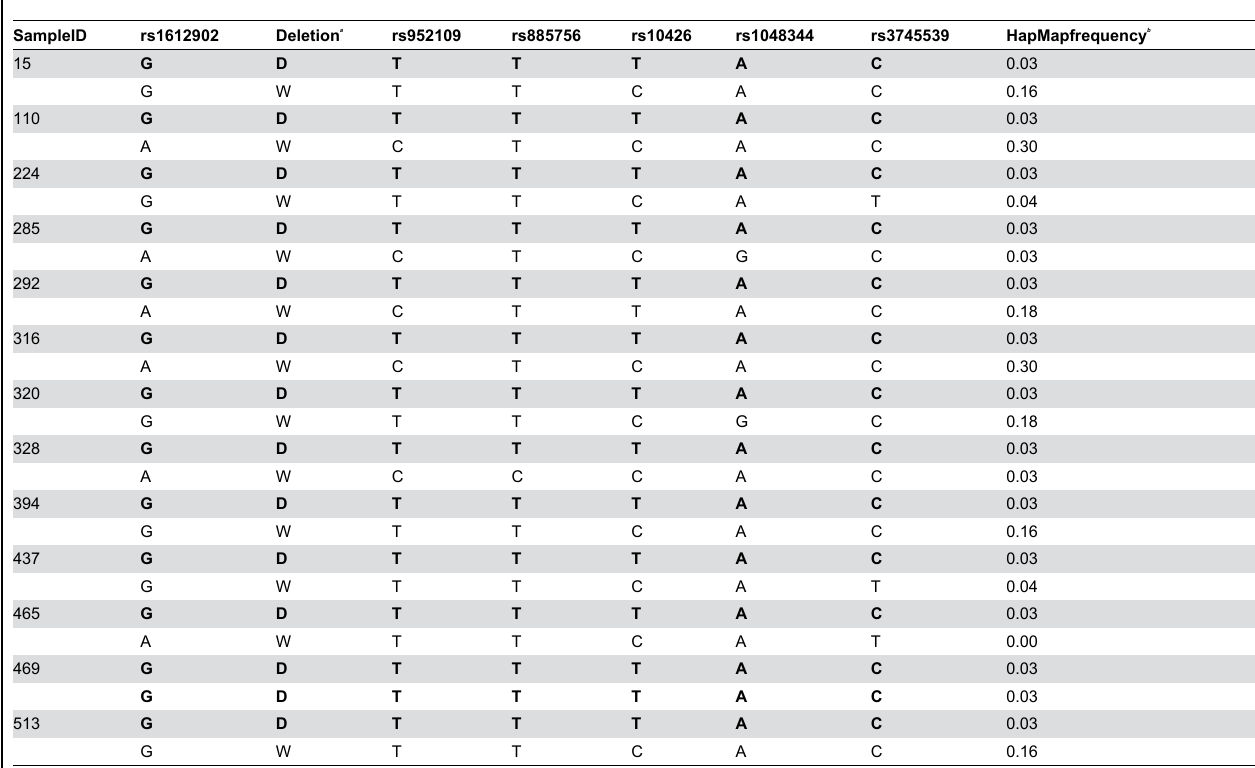
Table 1. Haplotypes estimated in individuals carrying deletions in the KLK9 gene.